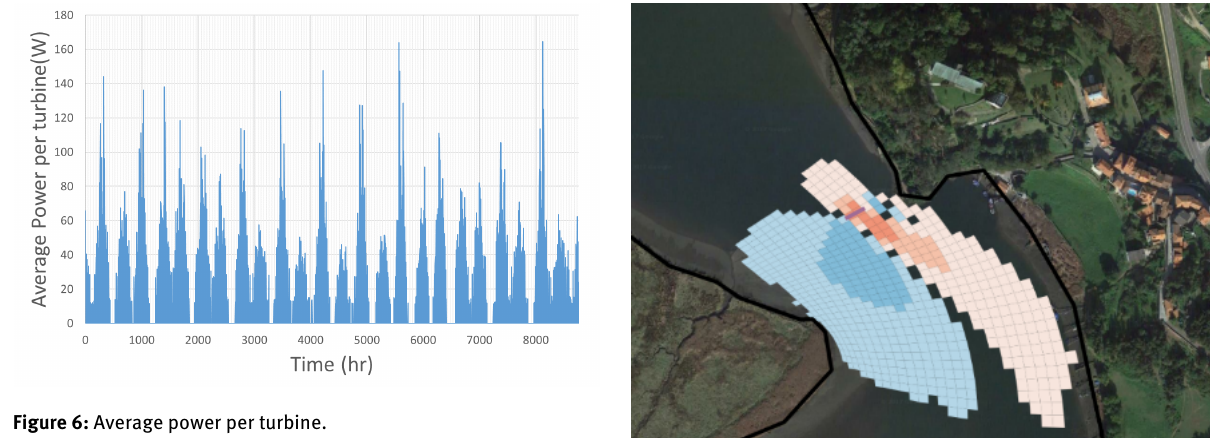
Figure 6: Average power per turbine. Table 1: Results from the study cells.